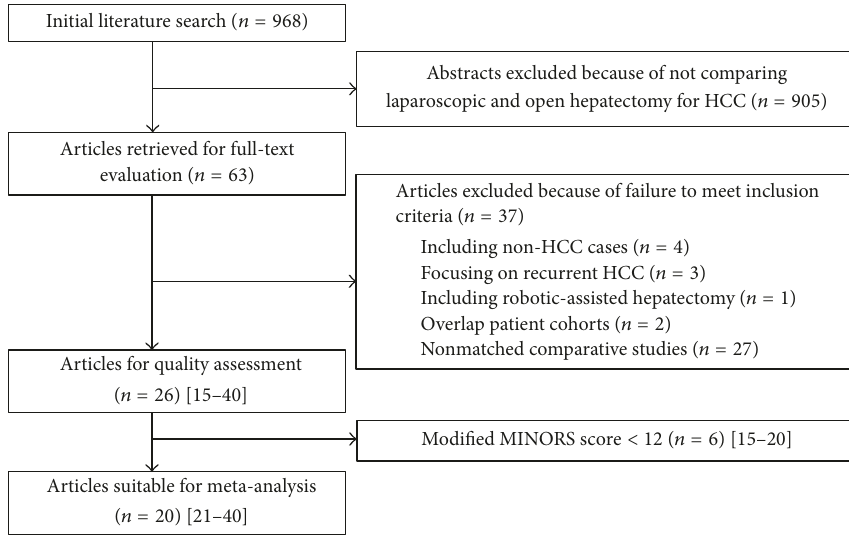
Figure 1: Flow chart of literature search